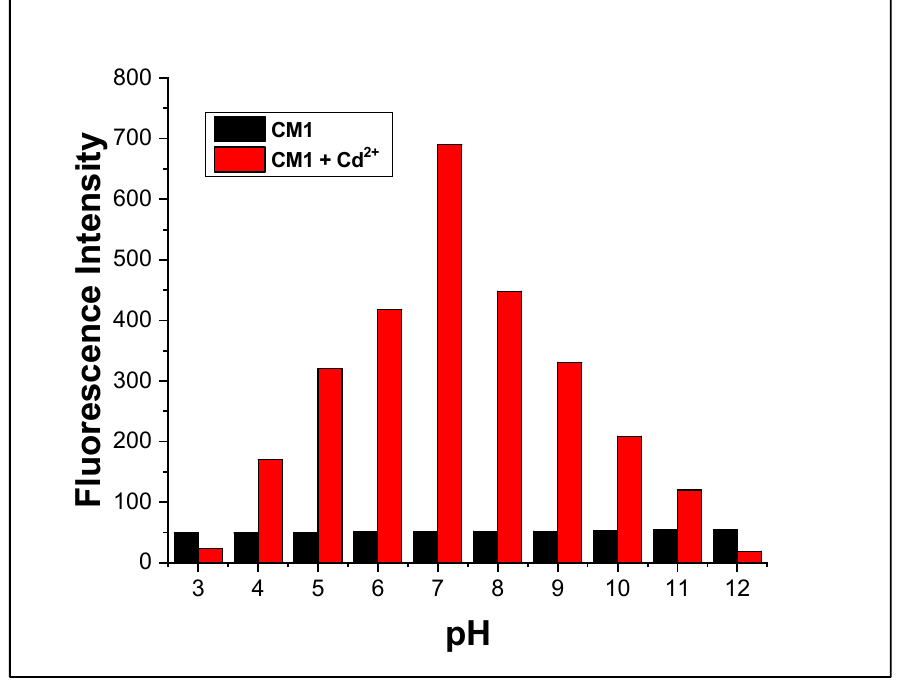
Figure 6. E ff ect of pH on fl uorescence intensity of CM1 and CM1 (10 µM) with Cd 2+ (18 µM) at λ ex Figure 6. Effect of pH on fluorescence intensity of CM1 and CM1 (10 µ M) with Cd 2+ (18 µ M) at = 390 nm and λ em = 610 nm . λ ex = 390 nm and λ em = 610